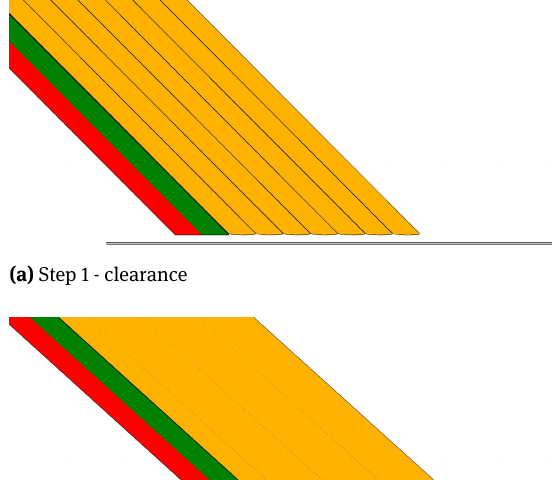
Figure 6: Steps of FEM analysis